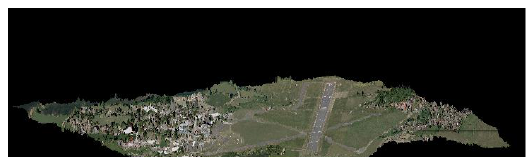
Figure 13. DEM generation by aerial image and satellite image under different